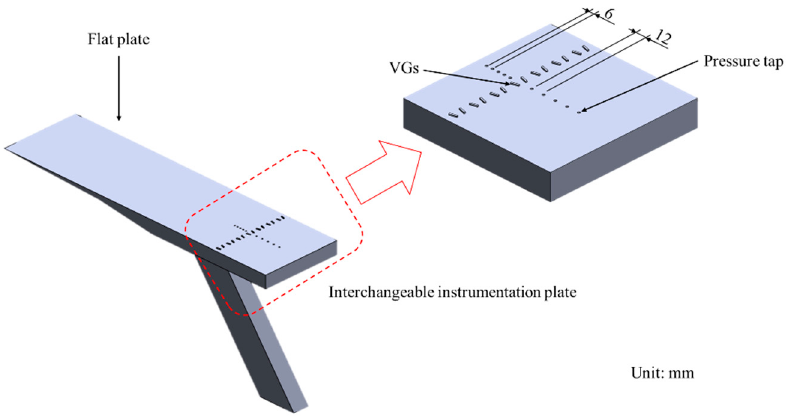
Figure 2. Test con fi guration.